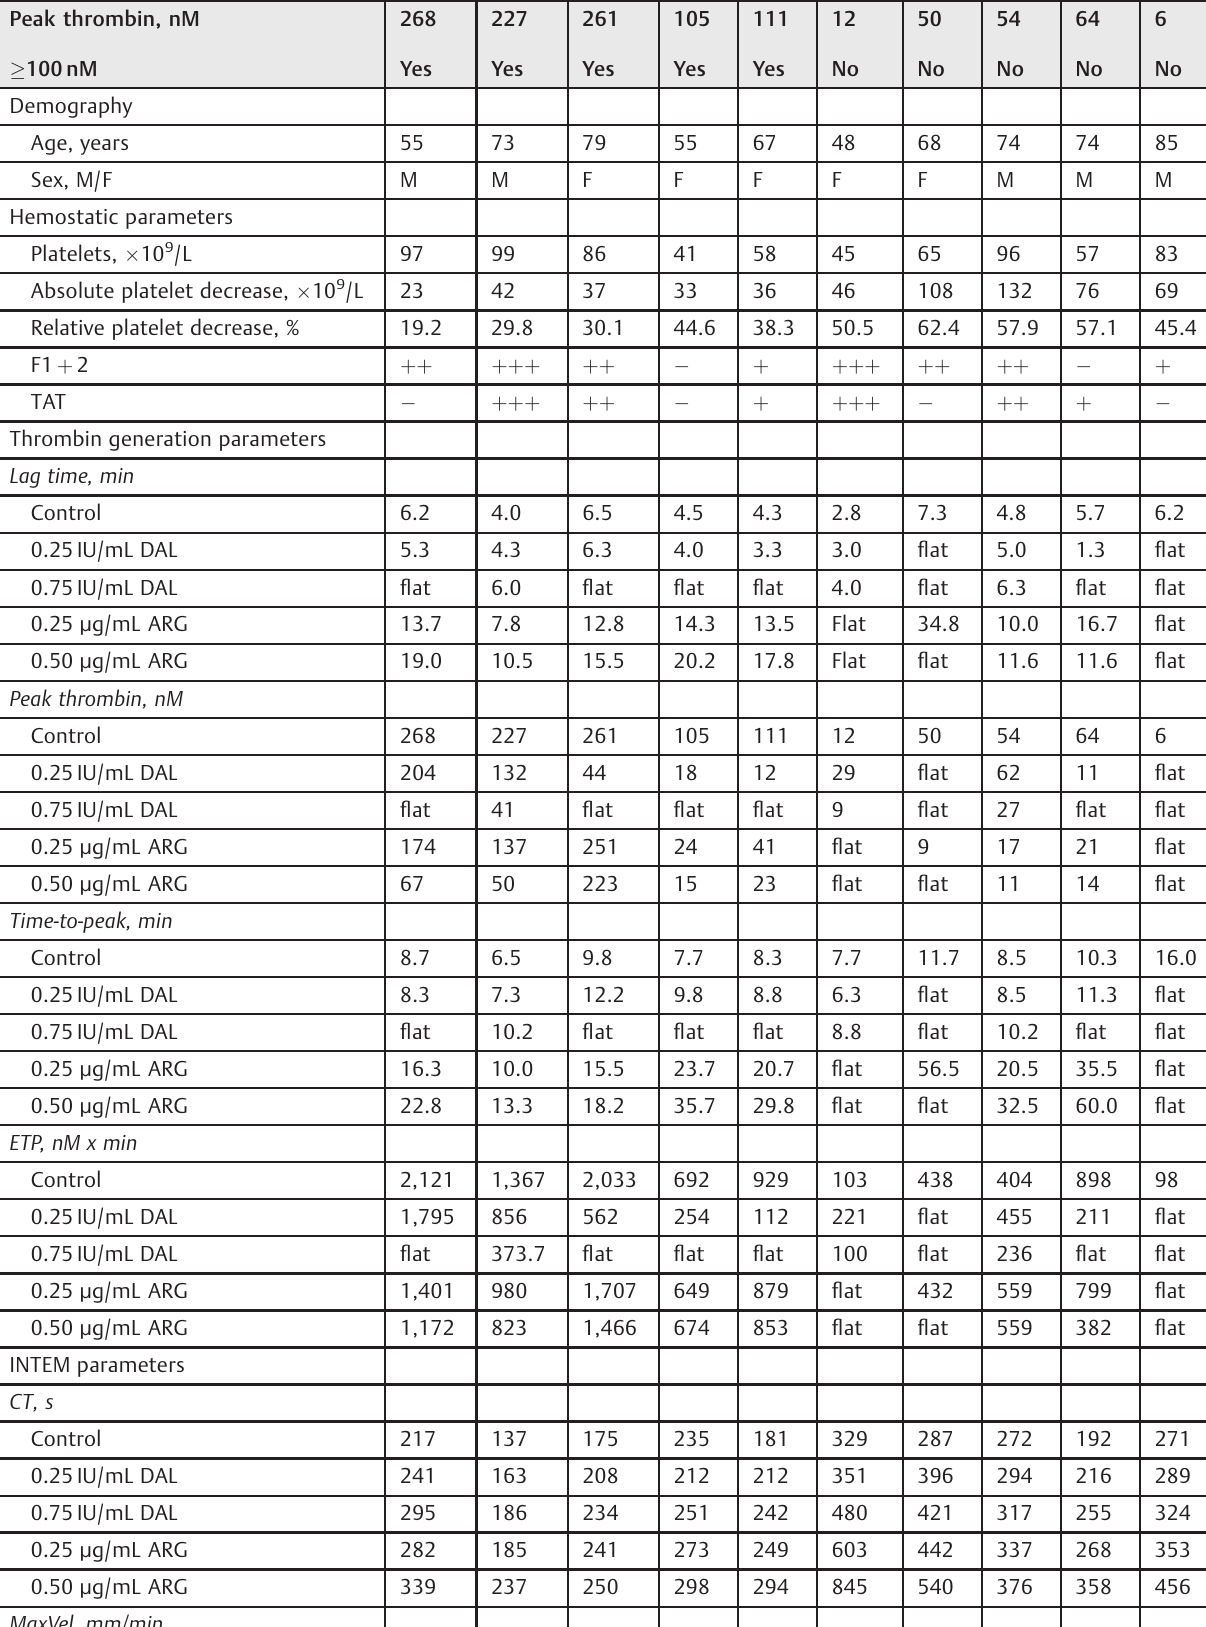
Table 3 Strati fi cation of the study population ( n ¼ 10) based on peak thrombin Peak thrombin,